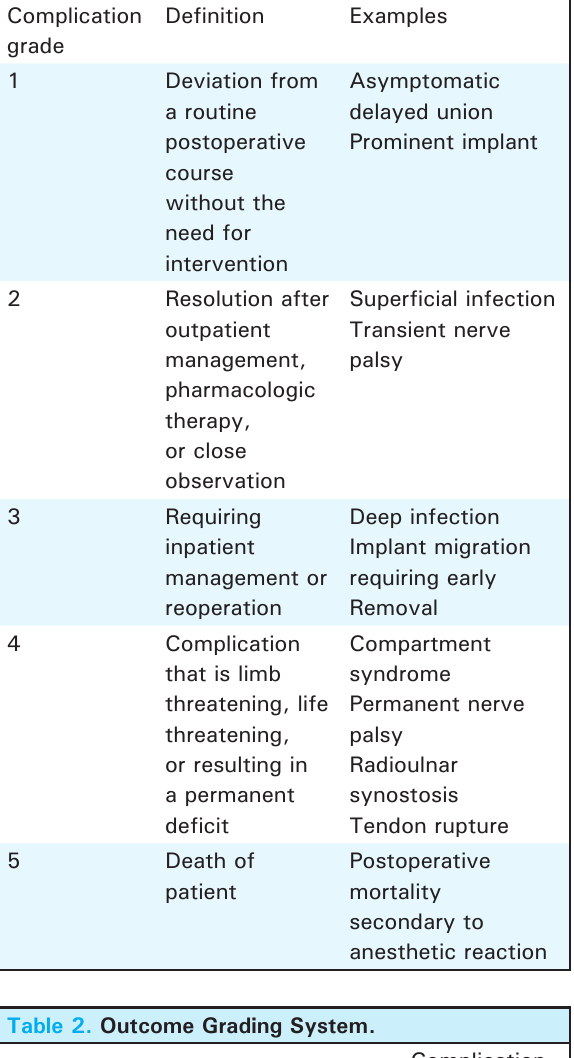
table 1. Modified Clavien-Dindo Classification of surgical complications.